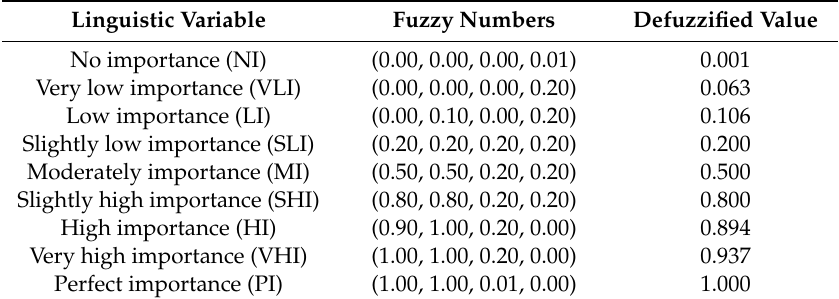
Table 1. Linguistic variables and the equivalent fuzzy interval and defuzzified values